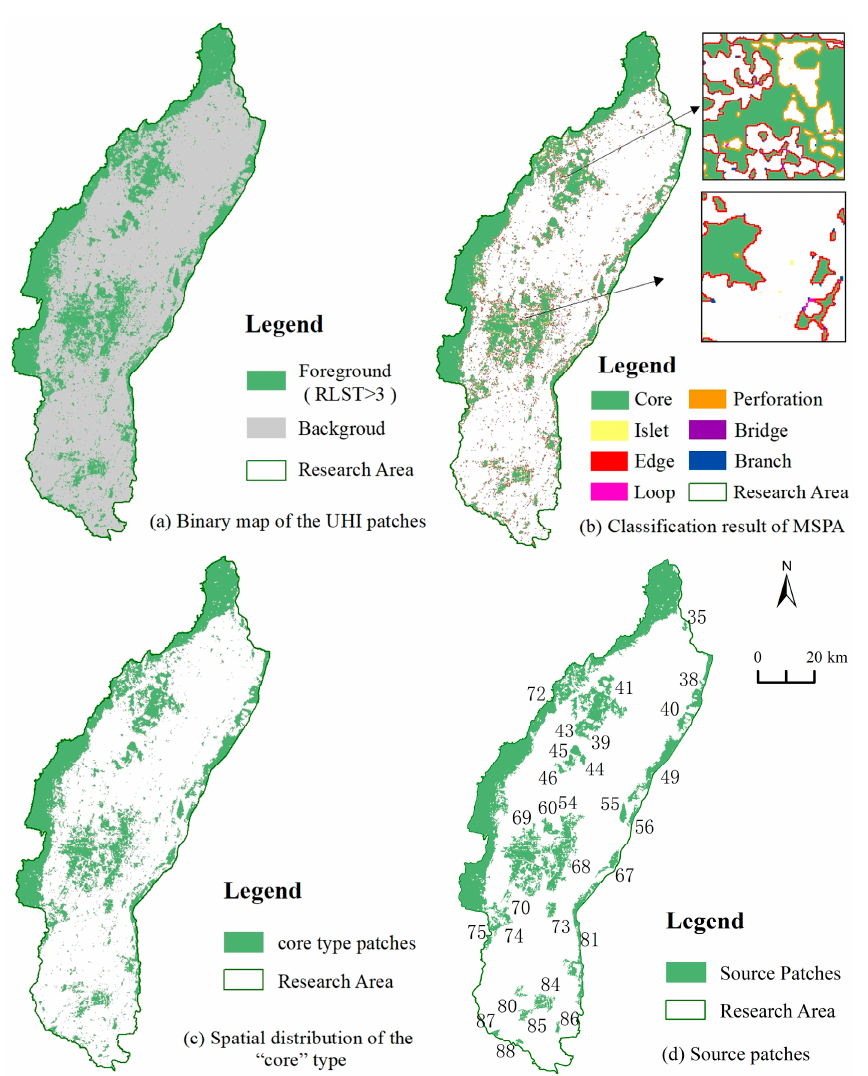
Figure 4. The process of selecting the source patches: ( a ) Binary map of the UHI patches. The RLST data are divided into foreground and background, where the foreground is data greater than 3. ( b ) Classification result of the UHI patches based on MSPA. In addition to the core type, the area of other types of patches is small, and the magnification in the corner plot shows the details of the patch. ( c ) Core type patches in the classification results. ( d ) The core patches ranked among the top 30 for connectivity were selected as source patches.